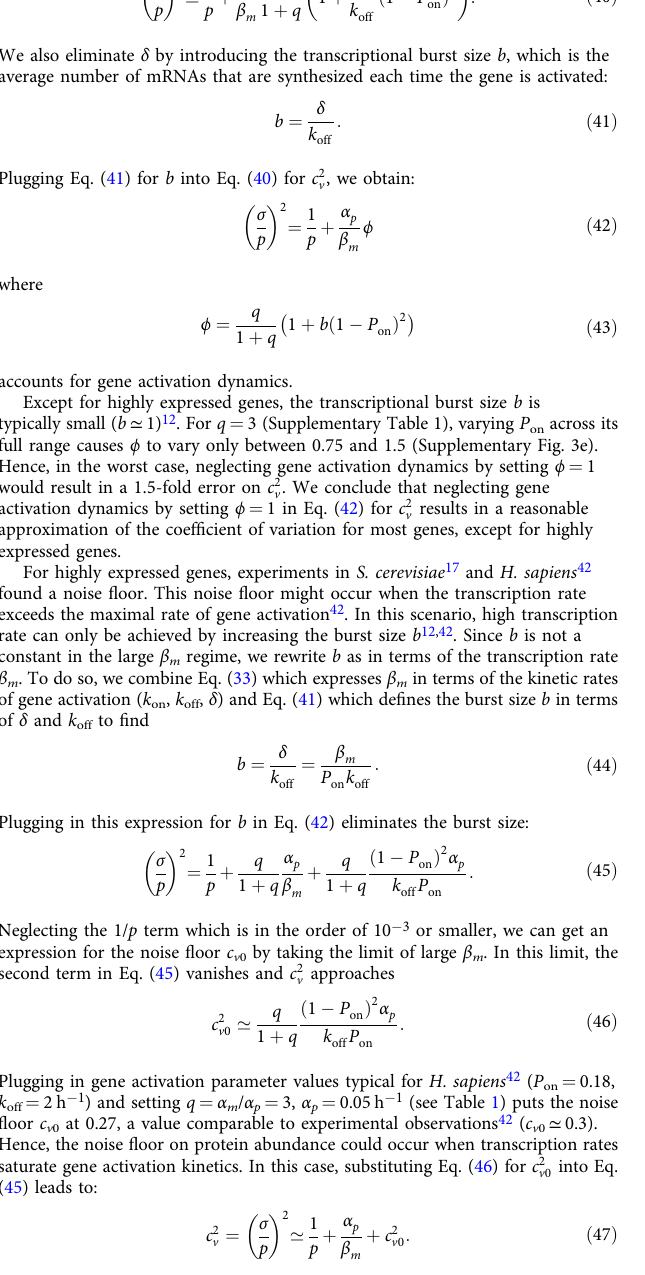
gene activation kinetics implies at most a 50% error on β m , or equivalently a 0.2 error on log 10 β m . This is small compared the dynamic range of transcription rates which vary over 2 – 3 order of magnitudes. Expression for the optimal translation/transcription ratio . We consider a protein of abundance p . The protein contributes a quantity f ( p ) to the organism ’ s fi tness. The cost of transcription Δ f β m is linear in the transcription rate m , the (pre-) mRNA length l m and the fi tness cost of transcription per nucleotide c m , ¼ c β : ð 48 Þ Δ f m m l m m The overall fi tness is thus F = f ( p ) − Δ f m . The fi tness function f ( p ) reaches its maximum f max at p = p * (Fig. 4a). Expanding f ( p ) around the optimum p = p * to second order, the overall fi tness becomes